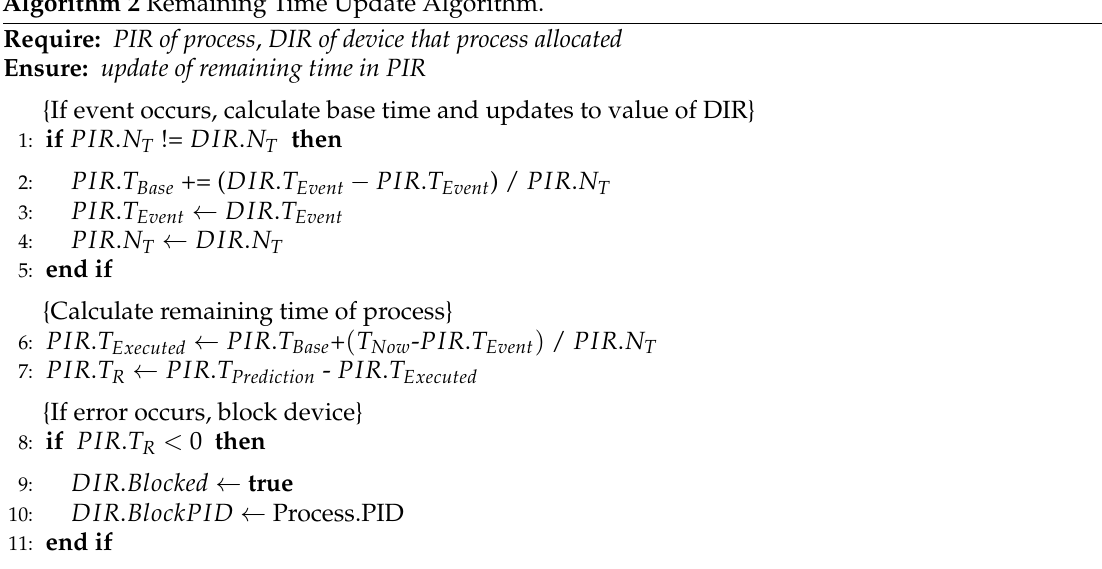
Algorithm 2 Remaining Time Update